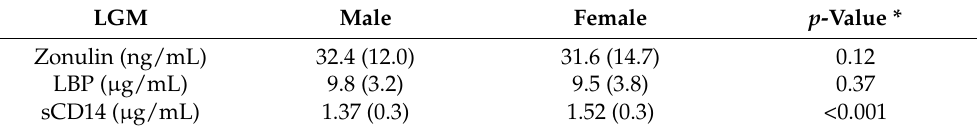
Table 3. LGM levels in male ( n = 250) and female ( n = 250) individuals separately. LGM Male Female p -Value * Zonulin (ng/mL)